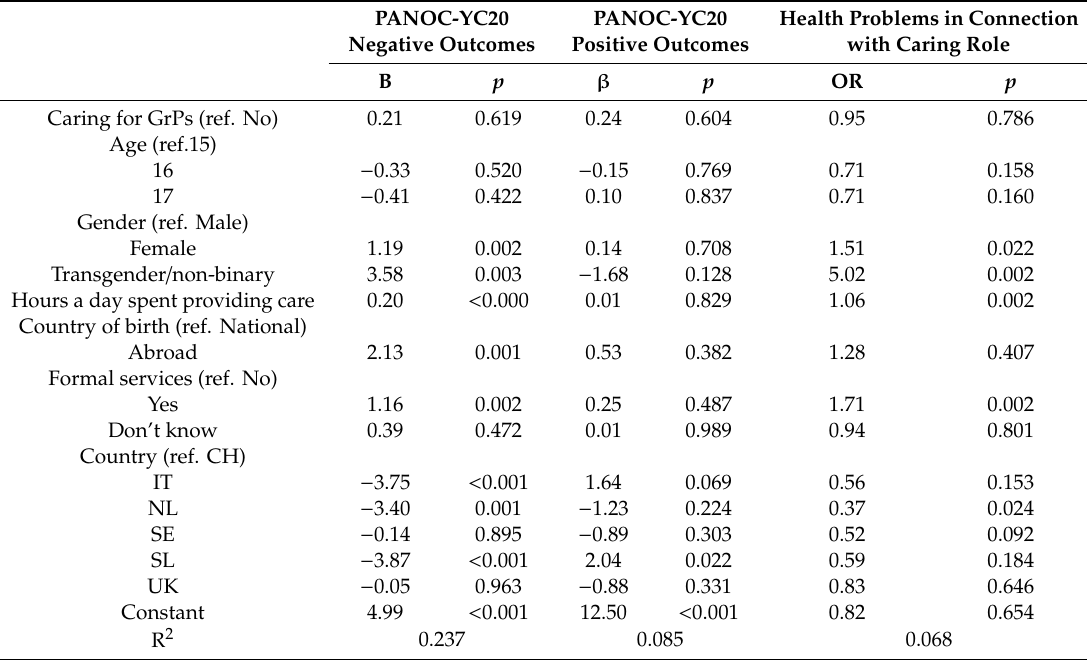
Table 4. Exposure factors to positive and negative caregiving outcomes and health problems among AYCs of OCRs and AYCs of GrPs (n = 817) when country is included in the regression model. PANOC-YC20 PANOC-YC20 Health Problems in Connection Negative Outcomes Positive Outcomes with Caring Role B p β p OR p Caring for GrPs (ref. No) 0.21 0.619 0.24 0.604 0.95 0.786 Age (ref.15) 16 − 0.33 0.520 − 0.15 0.769 0.71 0.158 17 − 0.41 0.422 0.10 0.837 0.71 0.160 Gender (ref. Male) Female 1.19 0.002 0.14 0.708 1.51 0.022 Transgender / non-binary 3.58 0.003 − 1.68 0.128 5.02 0.002 Hours a day spent providing care 0.20 < 0.000 0.01 0.829 1.06 0.002 Country of birth (ref. National) Abroad 2.13 0.001 0.53 0.382 1.28 0.407 Formal services (ref. No) Yes 1.16 0.002 0.25 0.487 1.71 0.002 Don’t know 0.39 0.472 0.01 0.989 0.94 0.801 Country (ref. CH) IT − 3.75 < 0.001 1.64 0.069 0.56 0.153 NL − 3.40 0.001 − 1.23 0.224 0.37 0.024 SE − 0.14 0.895 − 0.89 0.303 0.52 0.092 SL − 3.87 < 0.001 2.04 0.022 0.59 0.184 UK − 0.05 0.963 − 0.88 0.331 0.83 0.646 Constant 4.99 < 0.001 12.50 < 0.001 0.82 0.654 R 2 0.237 0.085